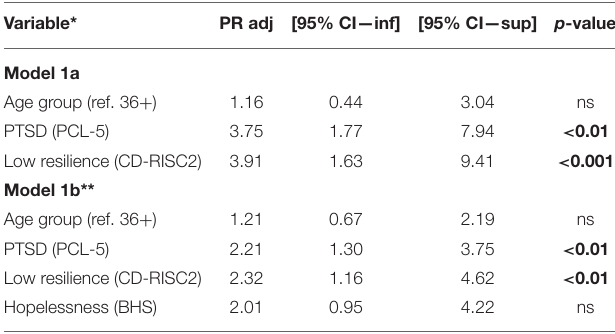
TABLE 5 | Multivariate log-binomial regression models for DSH